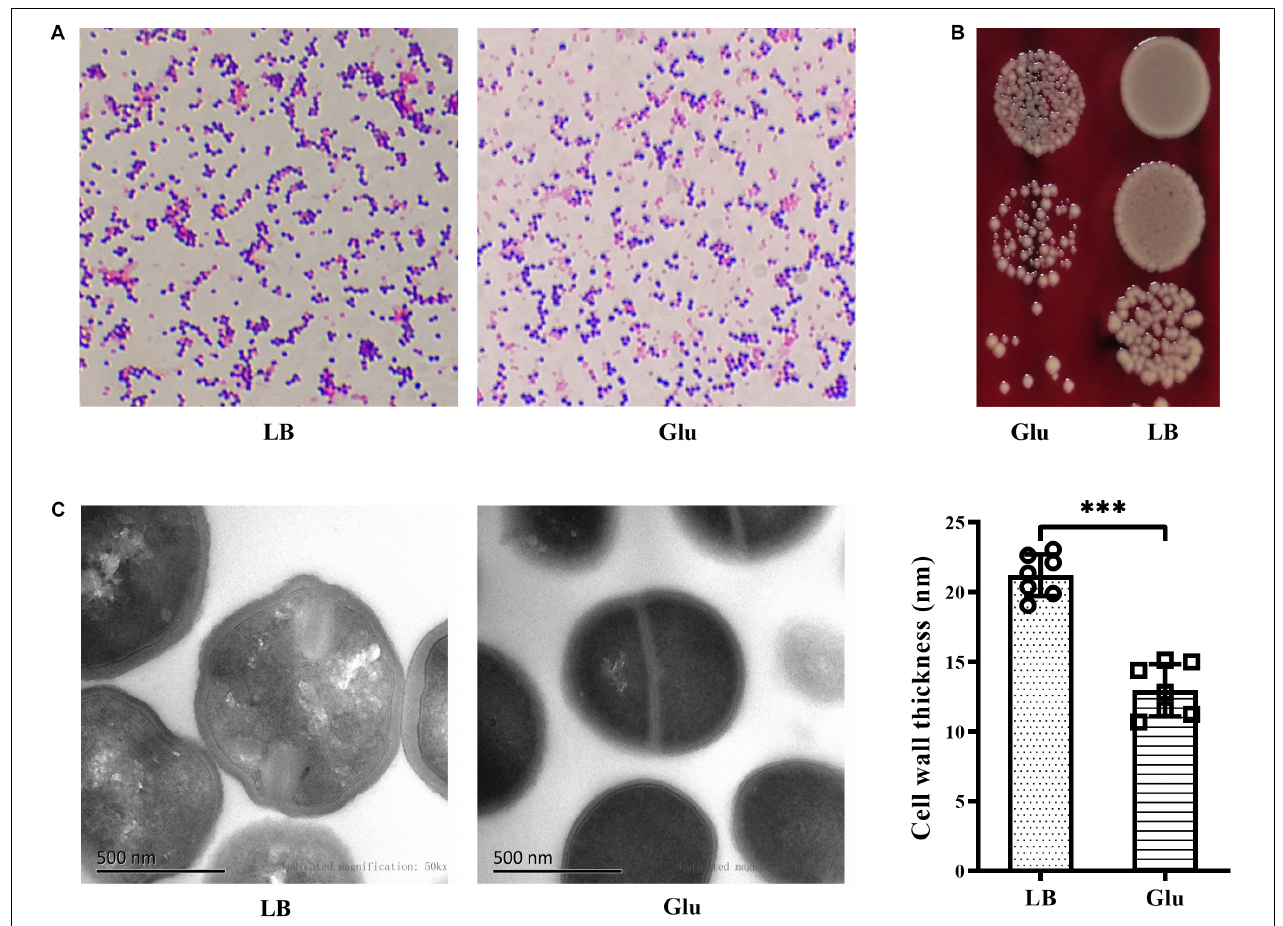
FIGURE 4 | Glucose reduced the thickness of the cell wall of S. aureus Newman. S. aureus Newman was cultured in LB medium with or without 25 mM glucose. (A) After cultured for 48 h, Gram-staining was used to examine morphology changes of S. aureus by glucose. (B) After 24 h, culture medium were diluted and plated on BA. (C) After 48 h, bacterial cells were analyzed by TEM, and the thickness of the cell wall was measured. Graphs show representative results from two independent experiments. ∗∗∗ p <